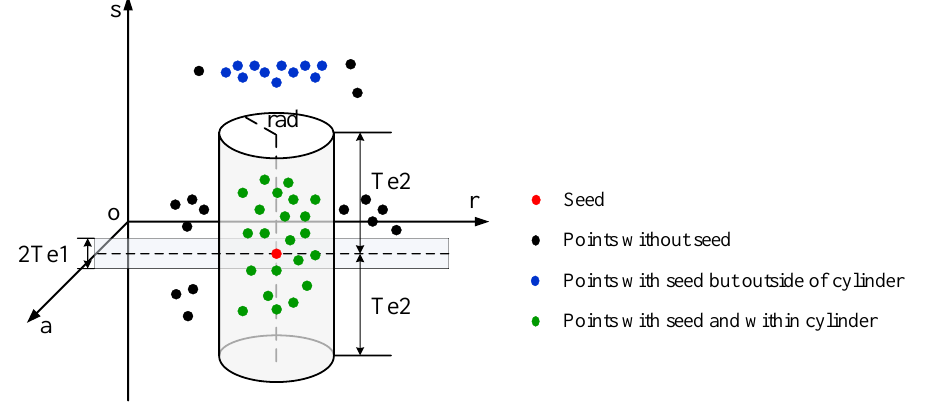
Figure 8. Illustration of FB scattering point detection in the radar coordinate system ( a , r , s ) . The ab- solute elevation of the seed is less than the threshold Te 1. The cylinder with radius rad and height 2 Te 2 is centered at the seed. Only the points with seed and within a cylinder are involved in density